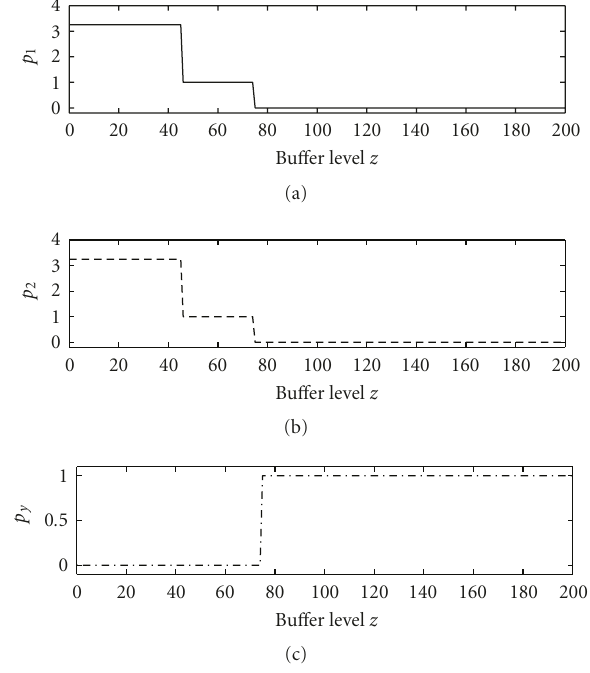
Figure 13: Power allocation as a function of z and channel state